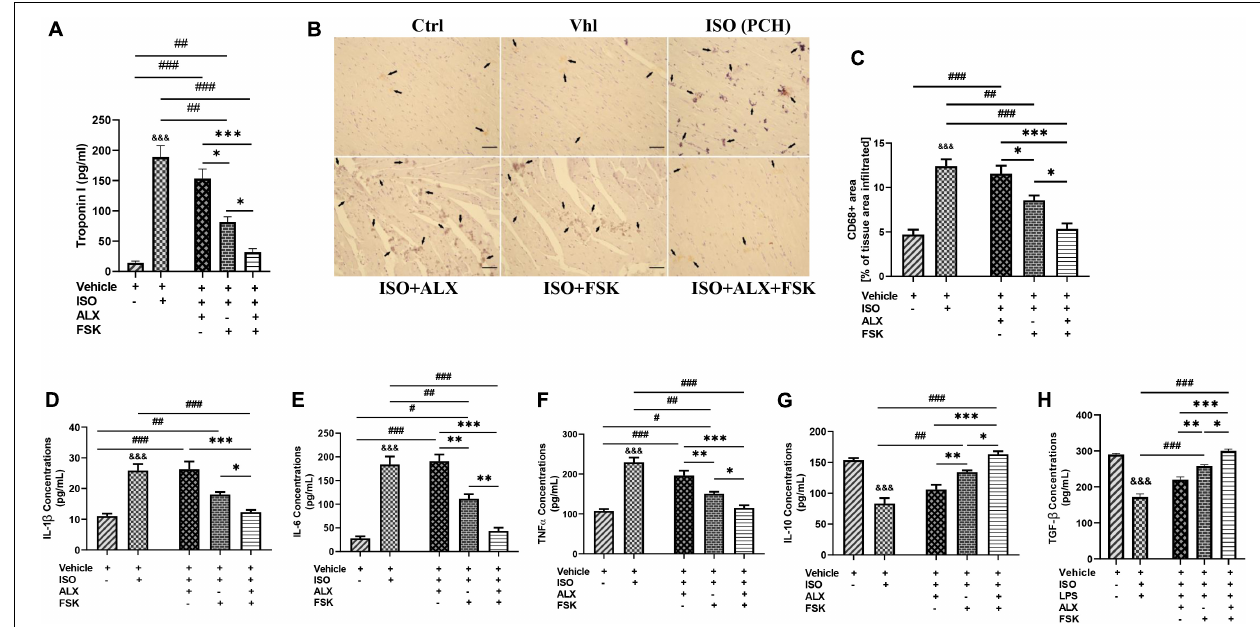
FIGURE 5 | ALX and FSK combination prevents proinflammatory responses aggravation in myocardia during CCS by preventing necrosis. (A) Graphical presentations of evaluated sera concentrations of troponin I from groups. The sera troponin I analysis was performed in triplicates ( n = 8 mice per treatment group). ∗ p < 0.05, ∗∗∗ p < 0.001, among the therapeutic groups; &&& p < 0.001 vs. ISO (PCH); ## p < 0.01, ### p < 0.001, vs. the therapeutic groups. (B,C) Representative CD68 IHC staining and graphical presentation of the extent of inflammatory cells infiltration into the myocardial of all groups. The Vhl mice group is representative of the Ctrl mice group in results illustrations due to similarity in their data ( n = 6–8 field of view per six to eight sections per six to seven hearts per group). (D–H) Graphical presentations of inflammatory cytokines (IL-1 β , IL-6, TNF α , IL-10, and TGF- β ) were evaluated by ELISA from all groups. The cytokines analysis was performed in triplicates ( n = 7–8 mice per treatment group). ∗ p < 0.05, ∗∗ p < 0.01, ∗∗∗ p < 0.001, among the therapeutic groups; &&& p < 0.001 vs. Vhl; # p < 0.05, ## p < 0.01, ### p < 0.001 vs. the therapeutic groups. Data are expressed as mean ± SEM. Data were analyzed using one-way ANOVA, followed by Tukey’s post hoc analysis.